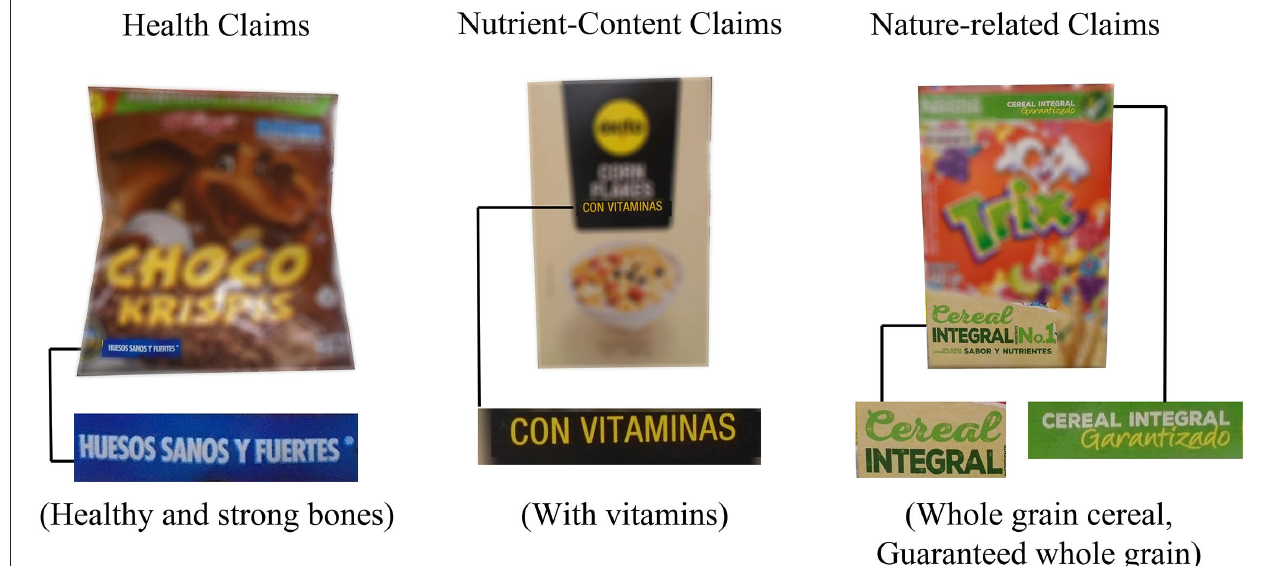
FIGURE 1 | Examples of each of the types of claims found on the products.